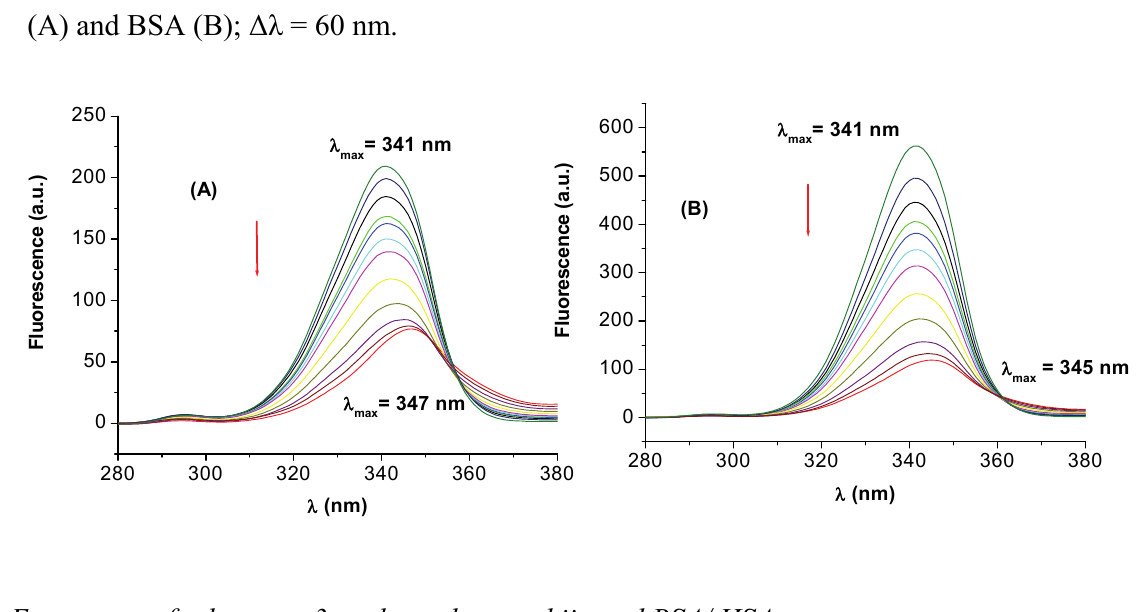
Figure 7. The effect of addition of I on the synchronous fluorescence spectrum of HSA (A) and BSA (B); Δλ = 60